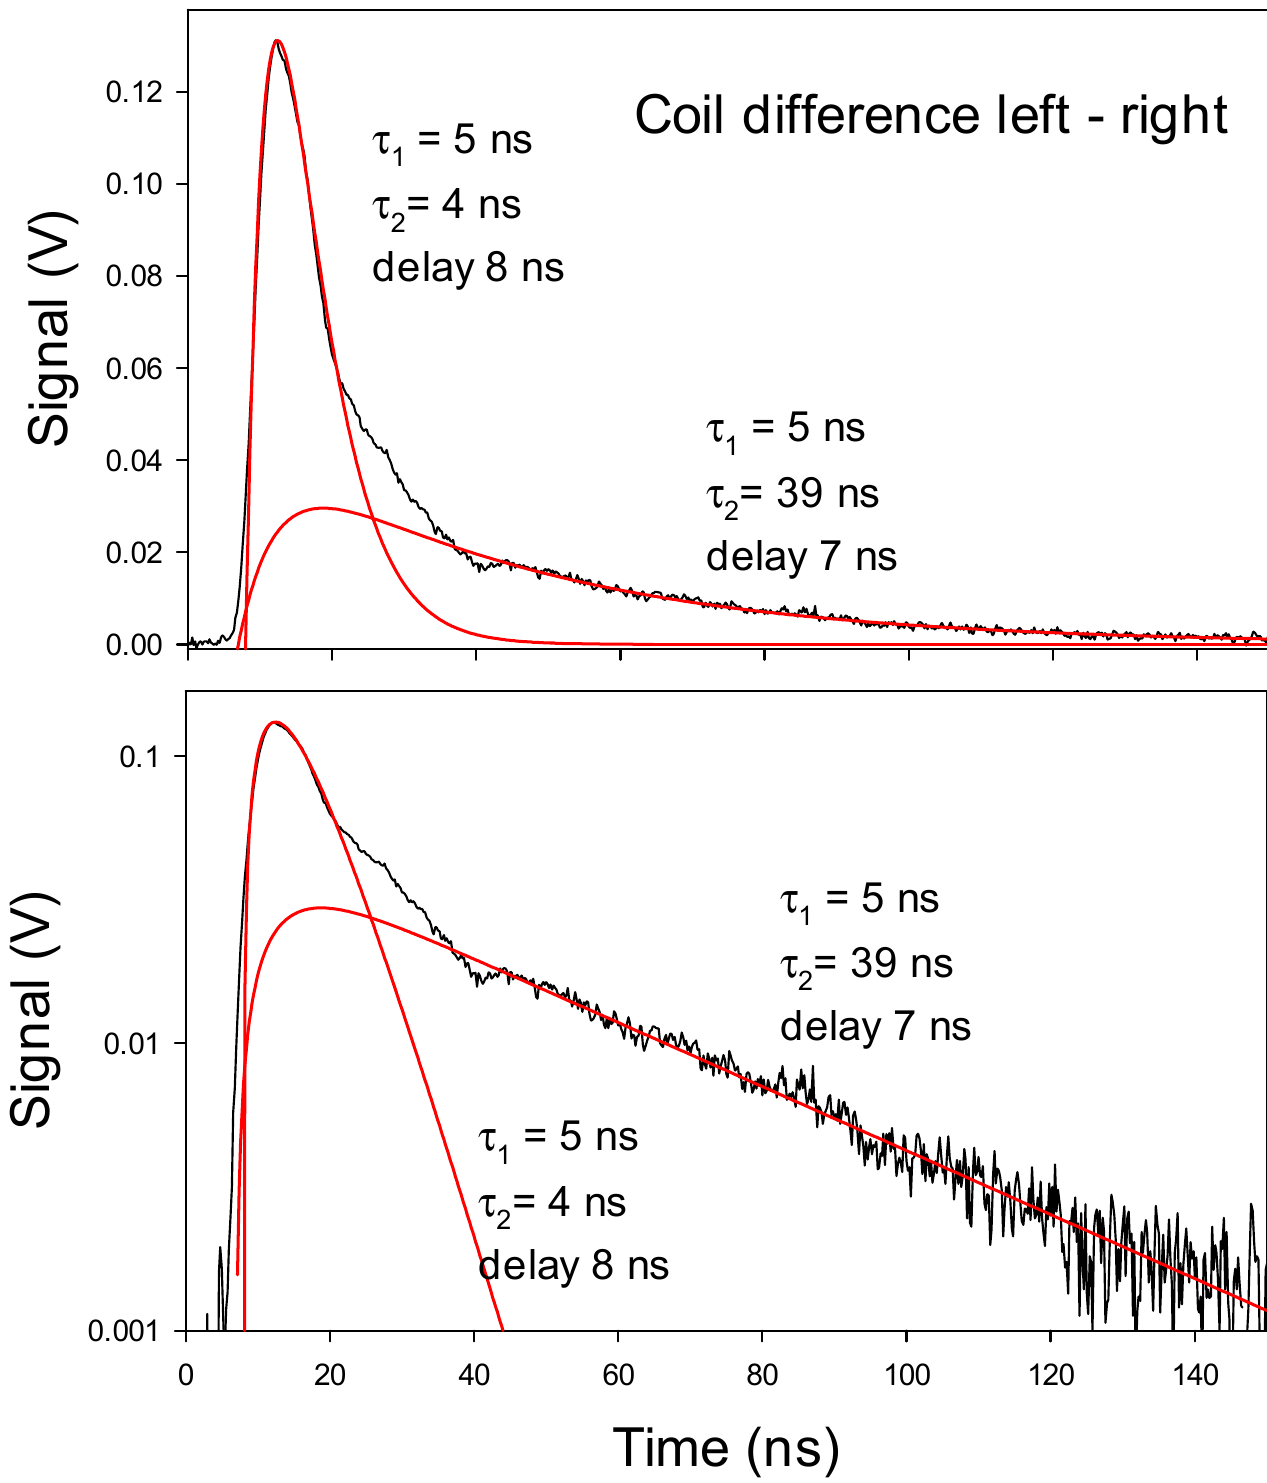
Figure 2. Linear and logarithmic plots of the differential signal from a current coil with a mainly positive particle signal passing through its center. Laser pulses 0.4 J, 10 Hz pulse repetition, 1064 nm laser light. D(0) in the source in Figure 1, 0.2 mbar D 2 . The red curves are calculated from Equation (3). The calculated delays of the meson curves after the laser pulse are given. The good exponentials are notable.